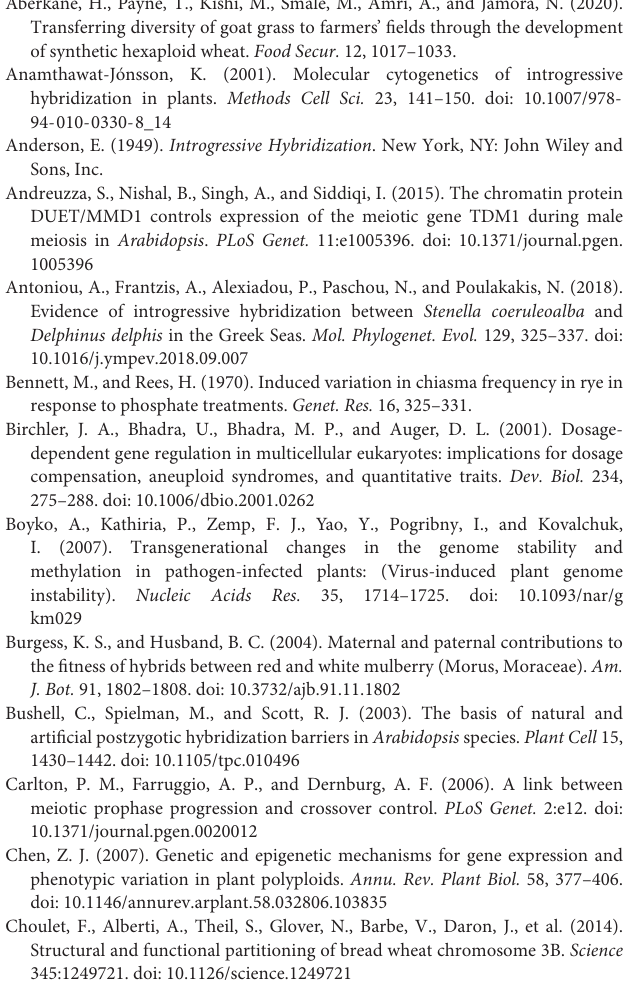
Supplementary Figure 2 | Consensus map of chromosomes 7A and 3B in two sets of pentaploid and hexaploid populations. Genetic gaps are indicated in green. (A) Consensus map of chromosome 7A. (B) Consensus map of chromosome 3B. Supplementary Data 1 | Genotyping data of SPW1